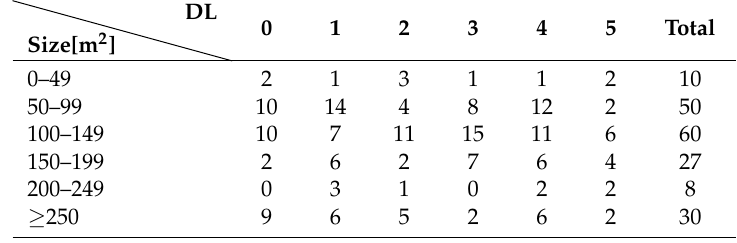
Table 1. Size and damage level (DL) of the buildings.